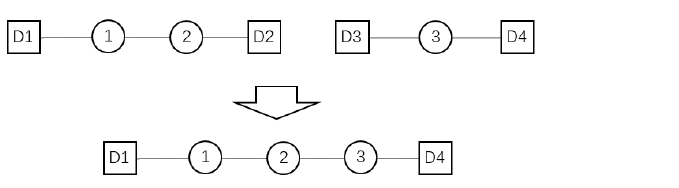
Figure 6. Illustration example of route combine.